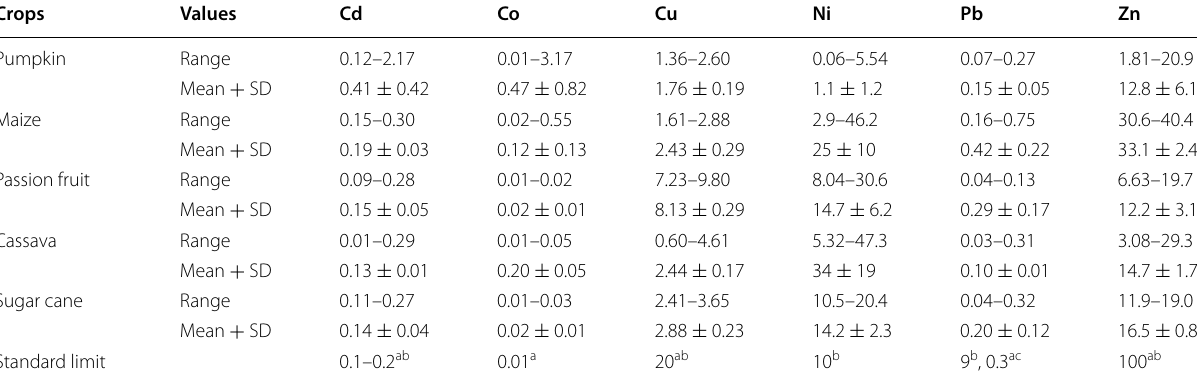
Table 3 Heavy metal content (mg/kg) of food crop of